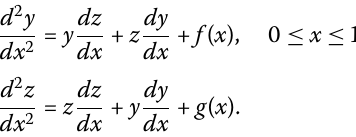
Figure 6 Graph of the exact solution y ( x ) = sin( x ) versus the approximate solution in fourth-order uniform mesh method for N = 64 and σ = 1 for Example